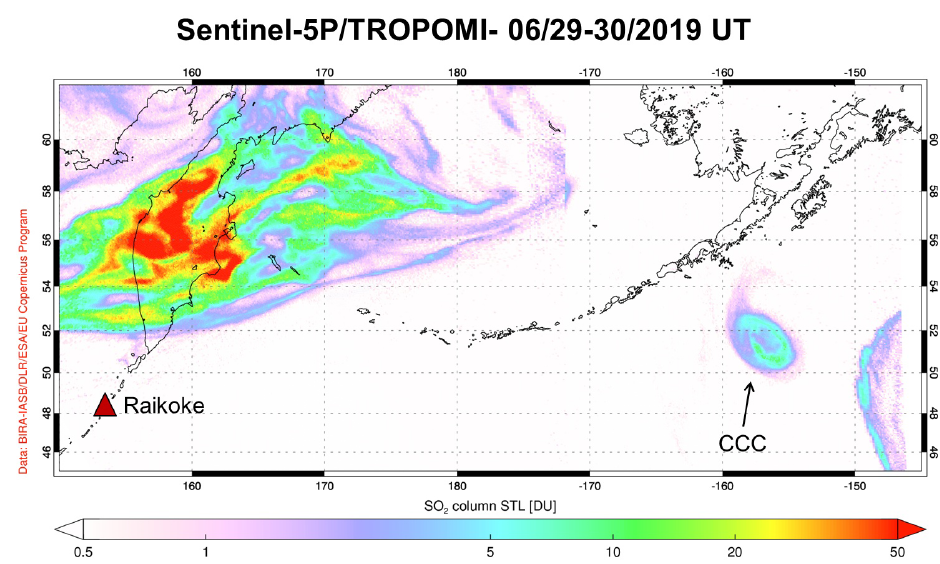
Figure 2. TROPOMI image of total column SO 2 (log scale), a week after the Raikoke eruption (image: courtesy Copernicus TROPOMI/Sentinel-5 Precursor SO 2 data, https://so2.gsfc.nasa.gov/, last access: 29 November 2021). The triangle represents the loca- tion of the Raikoke volcano. A coherent circular cloud is seen on 29 June 2019 centered at 51 ◦ N, 157 ◦ W. Note that this plot crosses the date line and so includes data from 29 (where the CCC is located) and 30 June